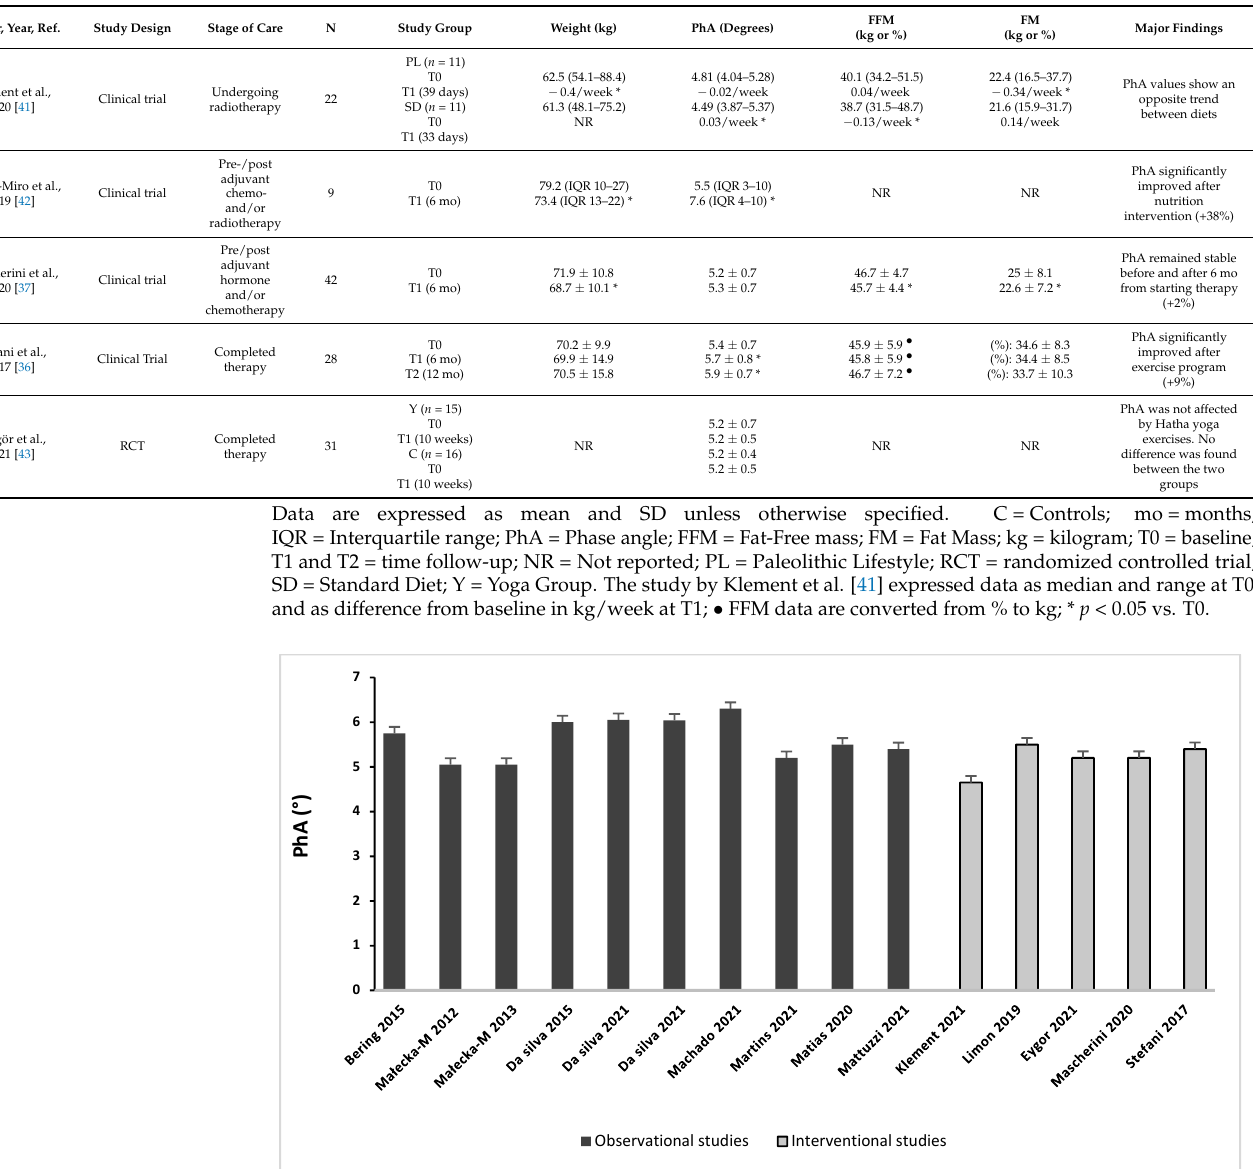
Table 3. Weight, phase angle and body composition variables extracted by the interventional studies.